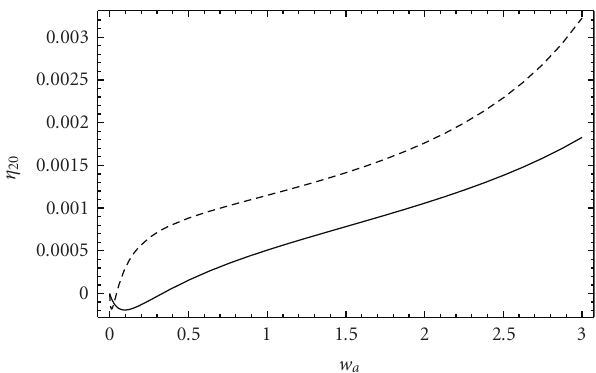
Figure 1: The dimensionless ratio between the present day values of f (cid:7)(cid:7) ( R ) and f ( R ) as function of the constant EoS w 0 of the corresponding quiessence model. Short dashed and solid lines refer to models with Ω M = 0 . 041 and 0 . 250, respectively.